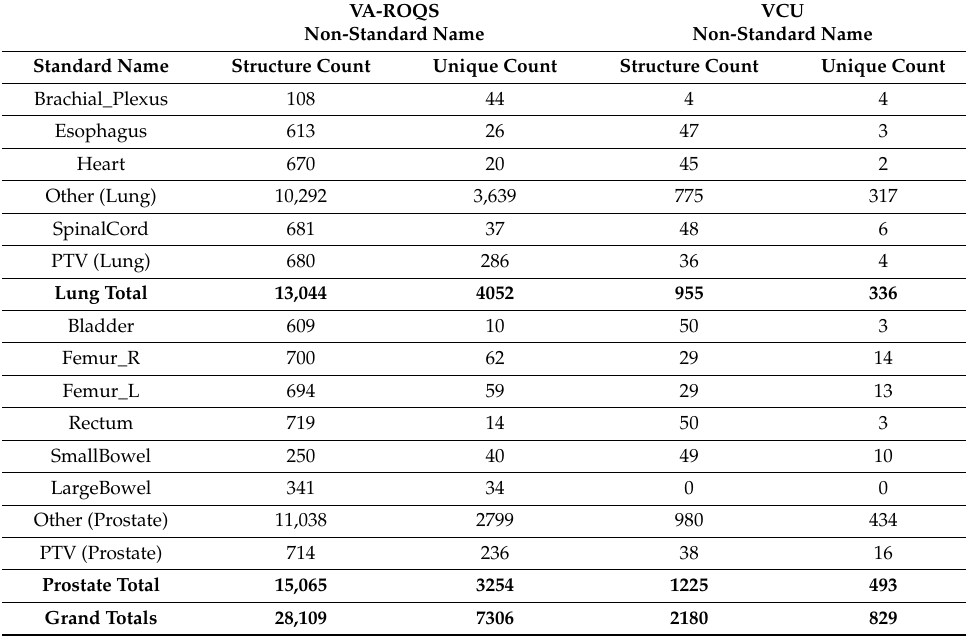
Table 2. Distribution of types of structures for prostate and lung cancer patients in the VA-ROQS and VCU